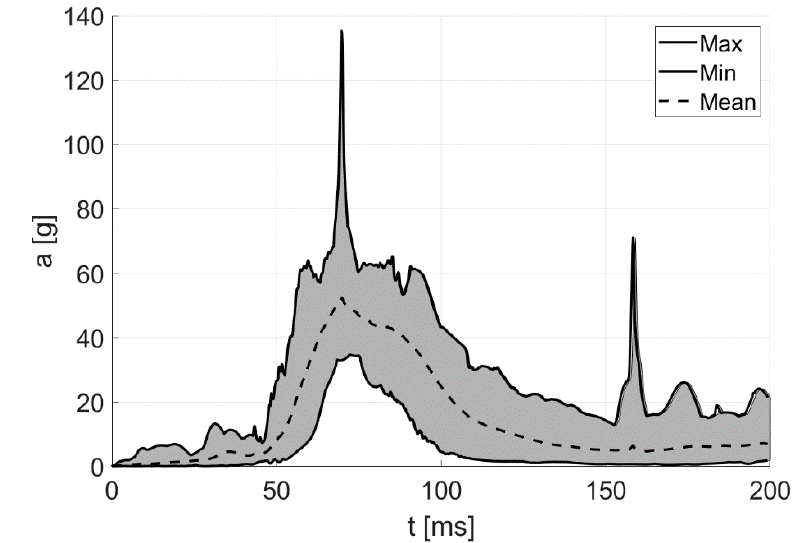
Figure 6. Head COG acceleration for 50 km/h pulse.